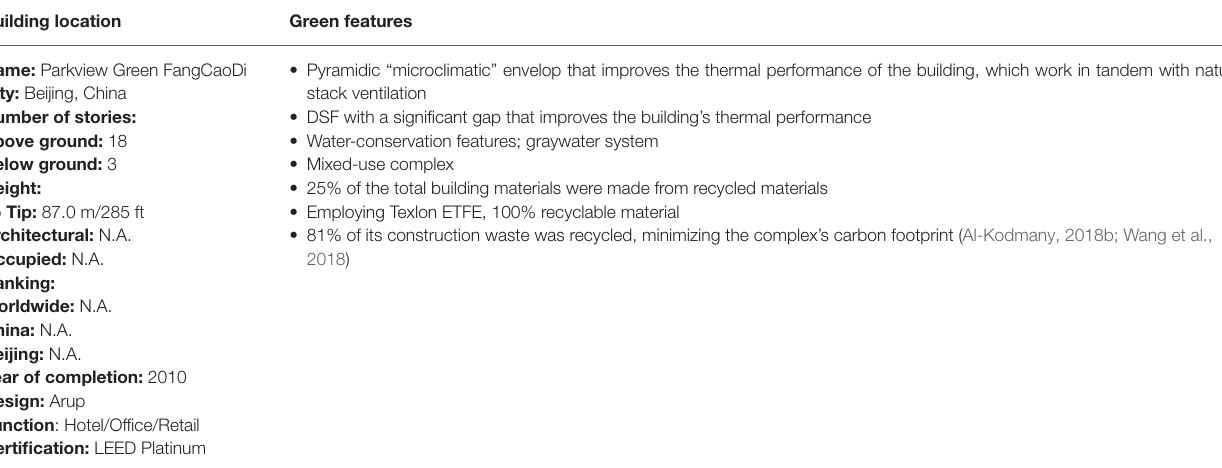
TABLE 11 | Parkview Green FangCaoDi: Key green features. Building location Green features